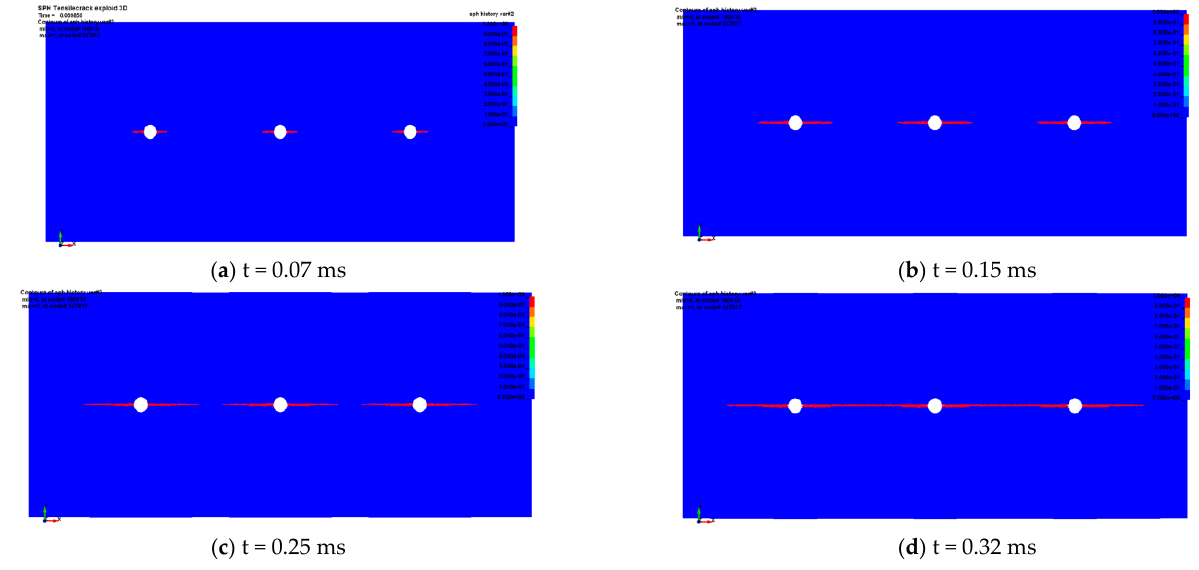
Figure 24. Stress evolution process of 500 mm spacing multi-hole shaped charge blasting.